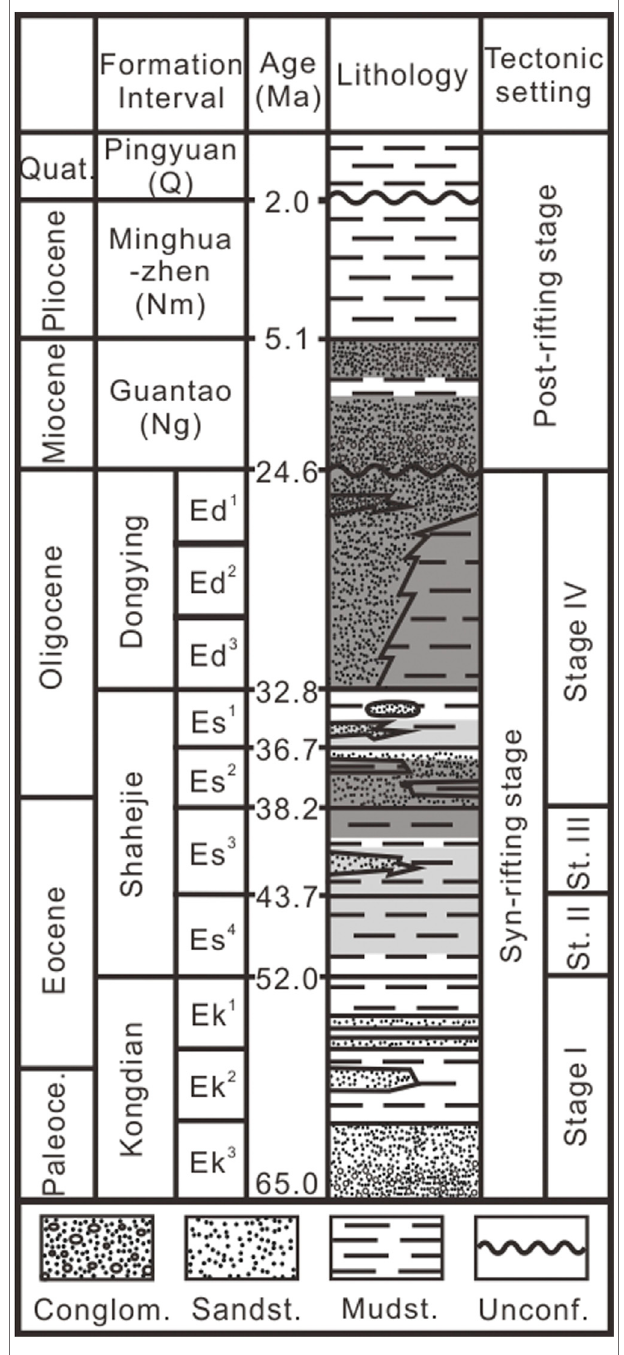
FIGURE 2 | Generalized Cenozoic stratigraphic column and tectonic setting of the study area. Quat., Quaternary; Paleoce., Paleocene; st., stage; conglom., conglomerate; sandst., sandstone; mudst., mudstone; unconf., unconformity.